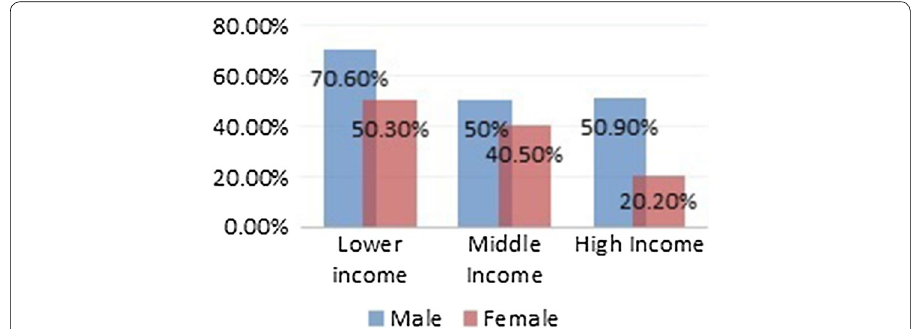
Fig. 1 Survey of diabetes death rates among different category of